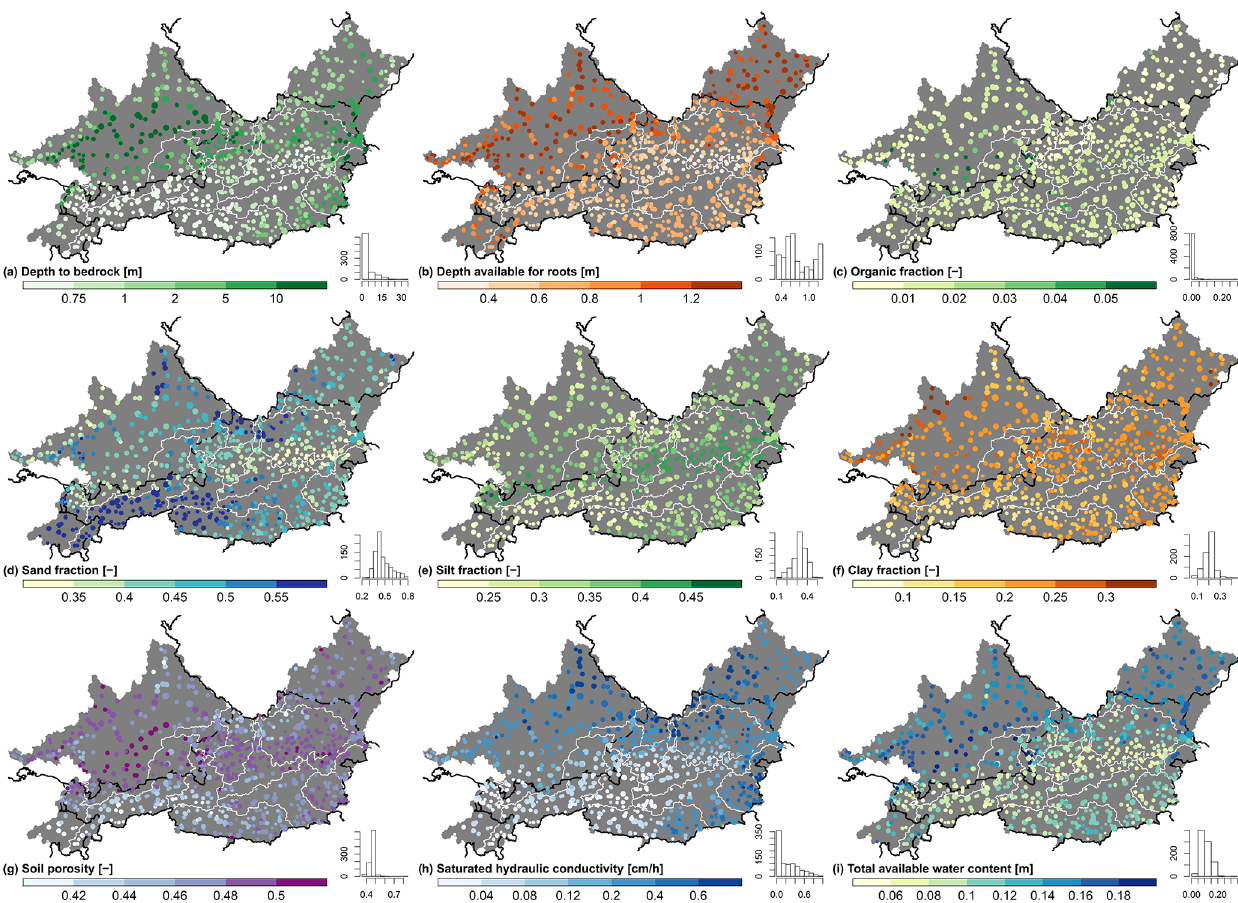
Figure 10. Spatial distribution of soil attributes representing the characteristics of the entire topographic catchment (basin delineation A, Fig. 2a). The histograms indicate the number of basins (out of 859) in each category. The size of the circles is proportional to the catchment area. © EuroGeographics for the administrative